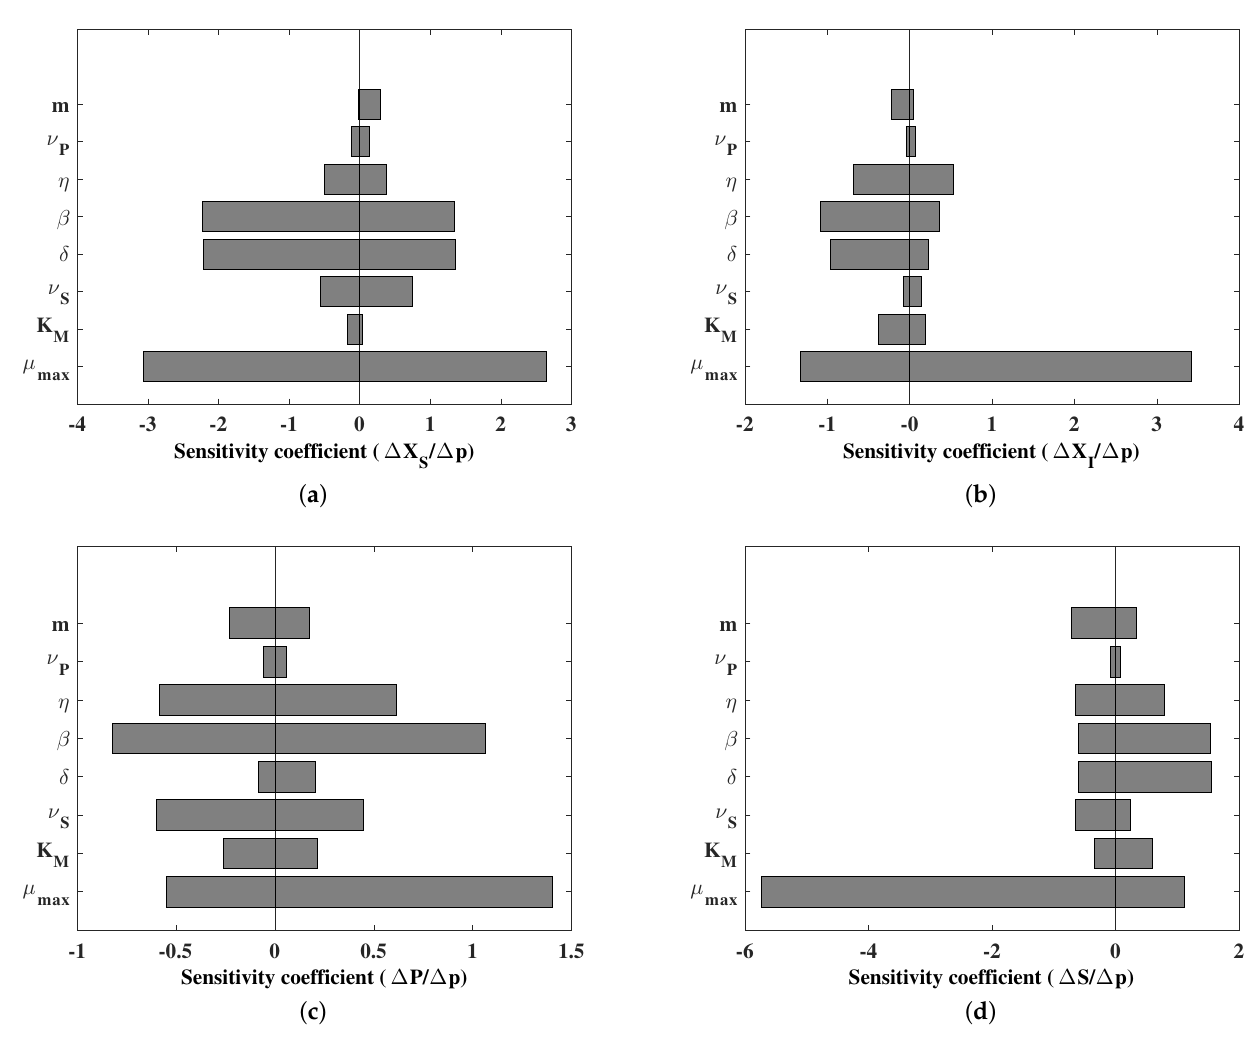
Figure 6. Parametric sensitivity analysis (±5% perturbations in the parameters for the situation described in Table 2). ( a ) Susceptible bacteria. ( b ) Infected bacteria. ( c ) Phages. ( d )